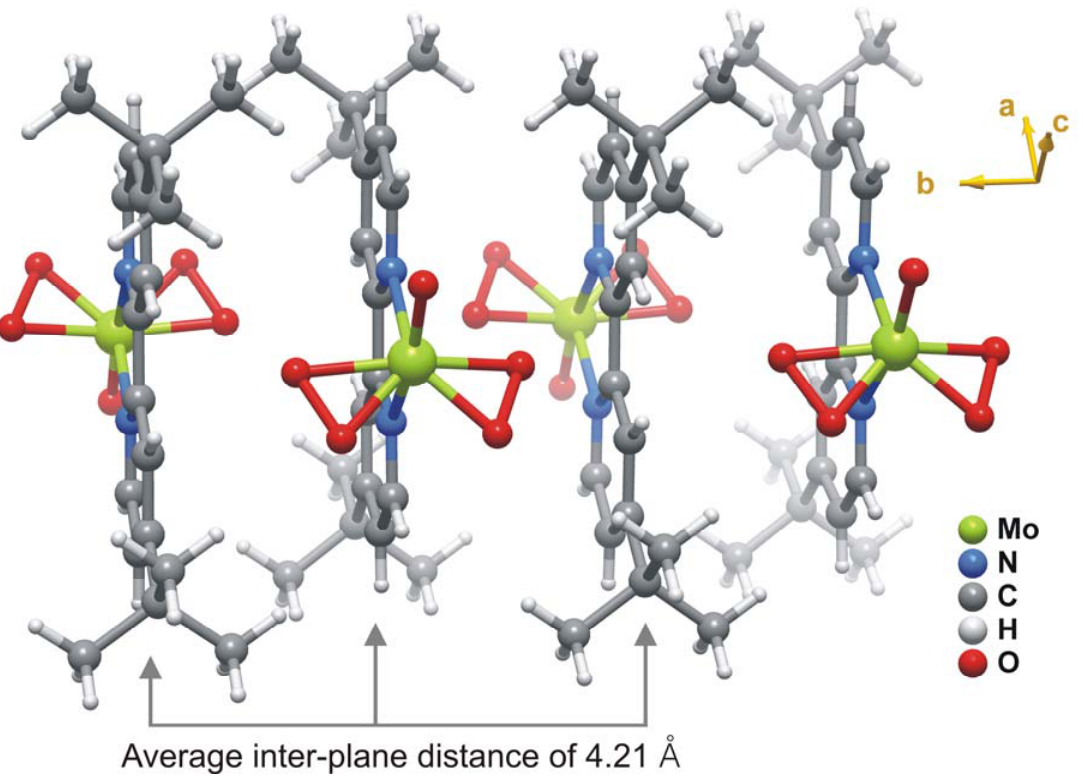
Figure 3. Schematic representation of the interdigitation of individual MoO(O complexes along the [010] direction of the unit cell. For simplicity only the most probable locations of the coordinated peroxo and oxo groups are